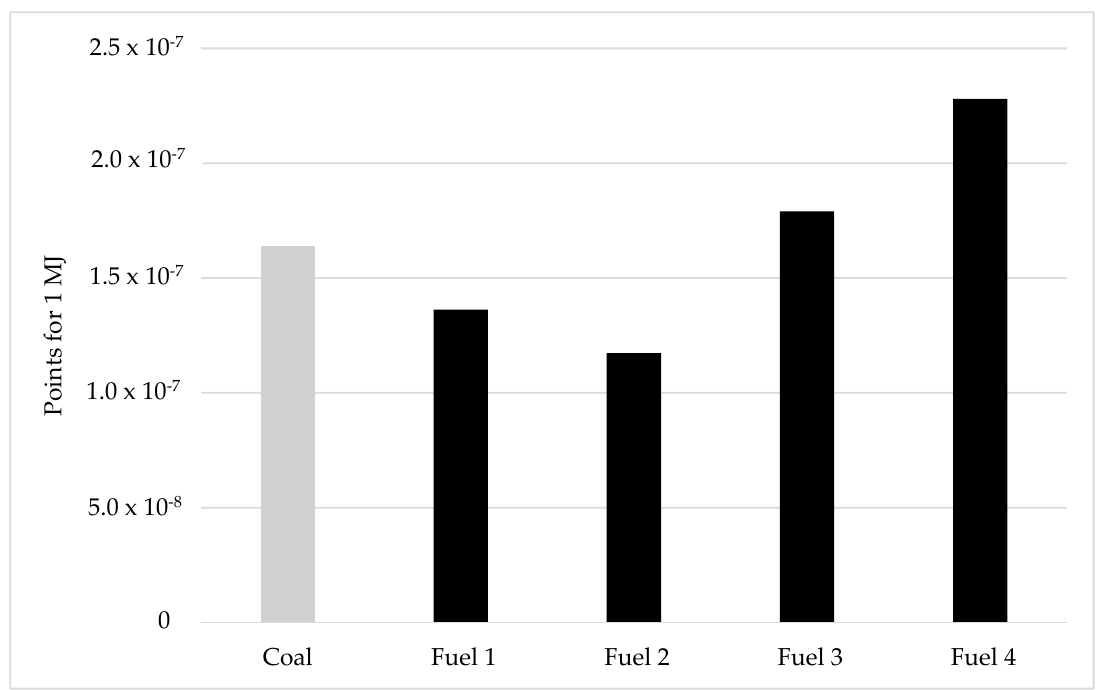
Figure 3. The total burden for people’s health expressed in points for 1 MJ of obtained energy.